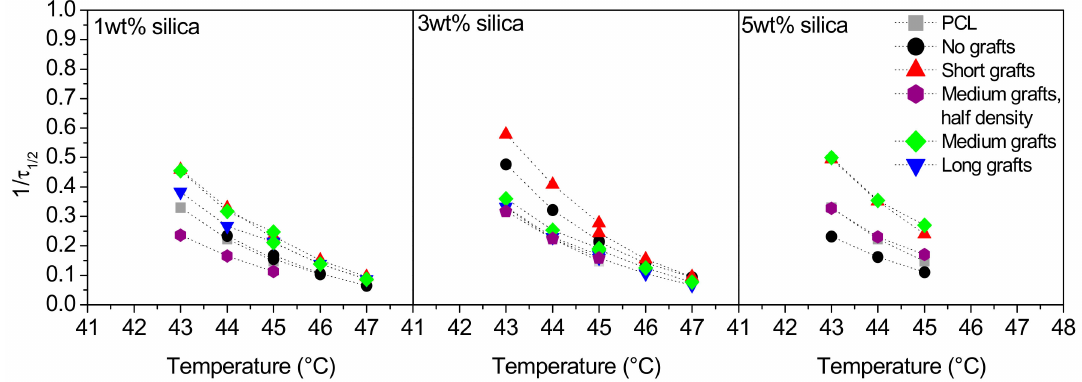
Figure 7. The inverse of half-time of crystallisation versus crystallisation temperature for PCL / silica composites based on PCL40 matrix and 1, 3 and 5 wt% filler (left to